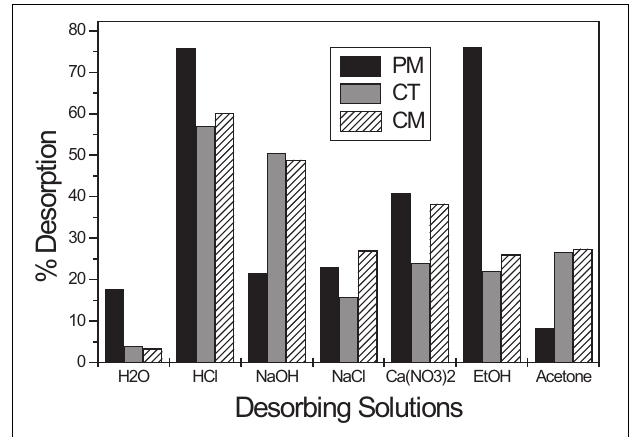
FIGURE 8 | Desorption of BY57 from the lignocellulosic